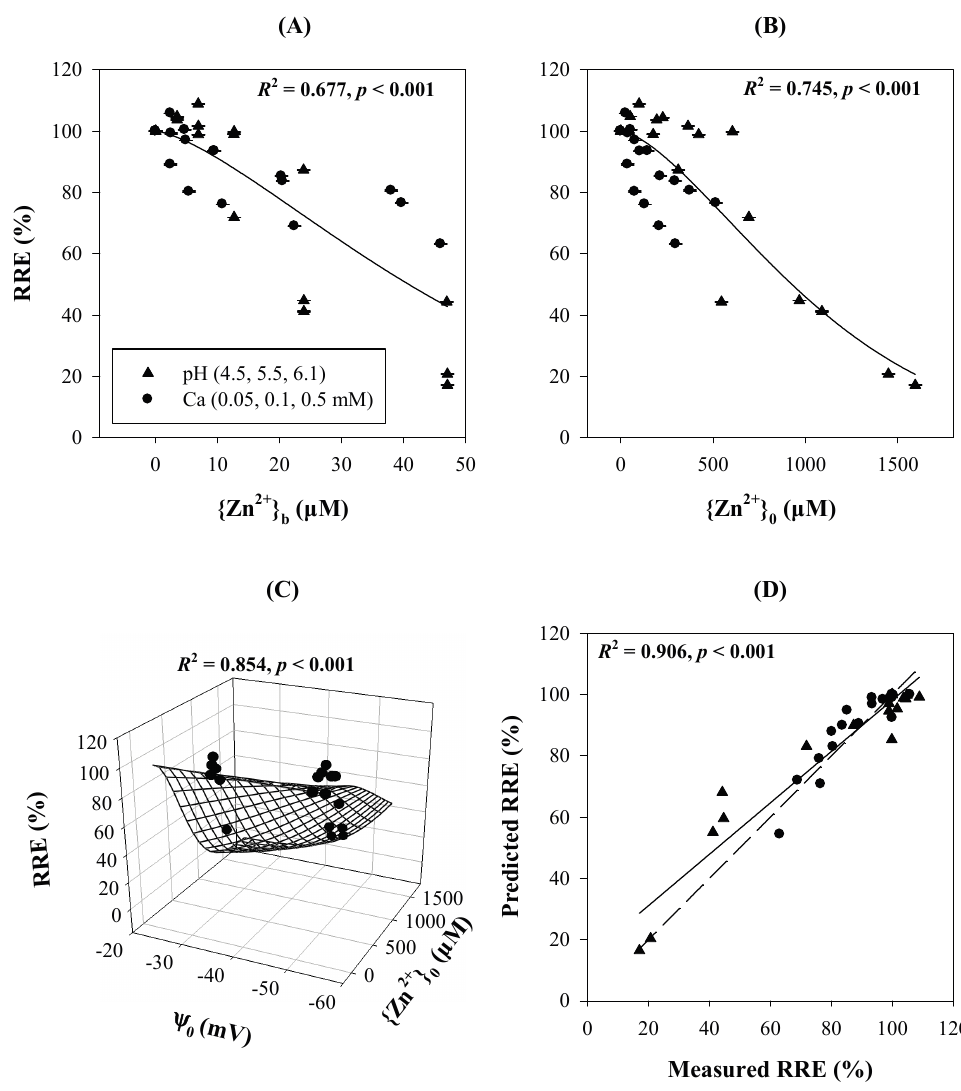
Figure 3. Relative root elongation (RRE, %) for wheat seedlings in response to Zn 2+ treatments under different pH values (4.5, 5.5, and 6.1) or Ca 2+ concentrations (0.05, 0.1, and 0.5 mM). Metal ion activities were expressed as ion activities in bulk-phase solutions ({Zn 2+ } b ) or activities at the PM surface ({Zn 2+ } 0 ). The equation RRE = 100/exp[( a {Zn 2+ } b ) b ] (Equation (8)) was used in ( A ); RRE = 100/exp[( a {Zn 2+ } 0 ) b ] (Equation (9)) was used in ( B ); RRE = 100/exp[( a (1 + c ψ 0 ){Zn 2+ } 0 ) b ] (Equation (10)) was used in ( C ); and RRE = 100{1 − 1/exp( p {Ca 2+ } 0 )}/exp[( a (1 + c ψ 0 ){Zn 2+ } 0 ) b ] (Equation (11)) was used in ( D ). The dashed line in ( D ) shows the 1:1 slope relationship. Data were obtained from Wang et al.